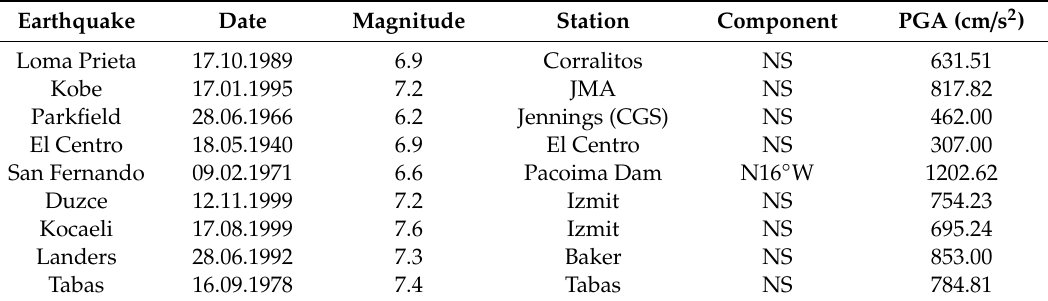
Table 1. Ground motion records used in the analysis.